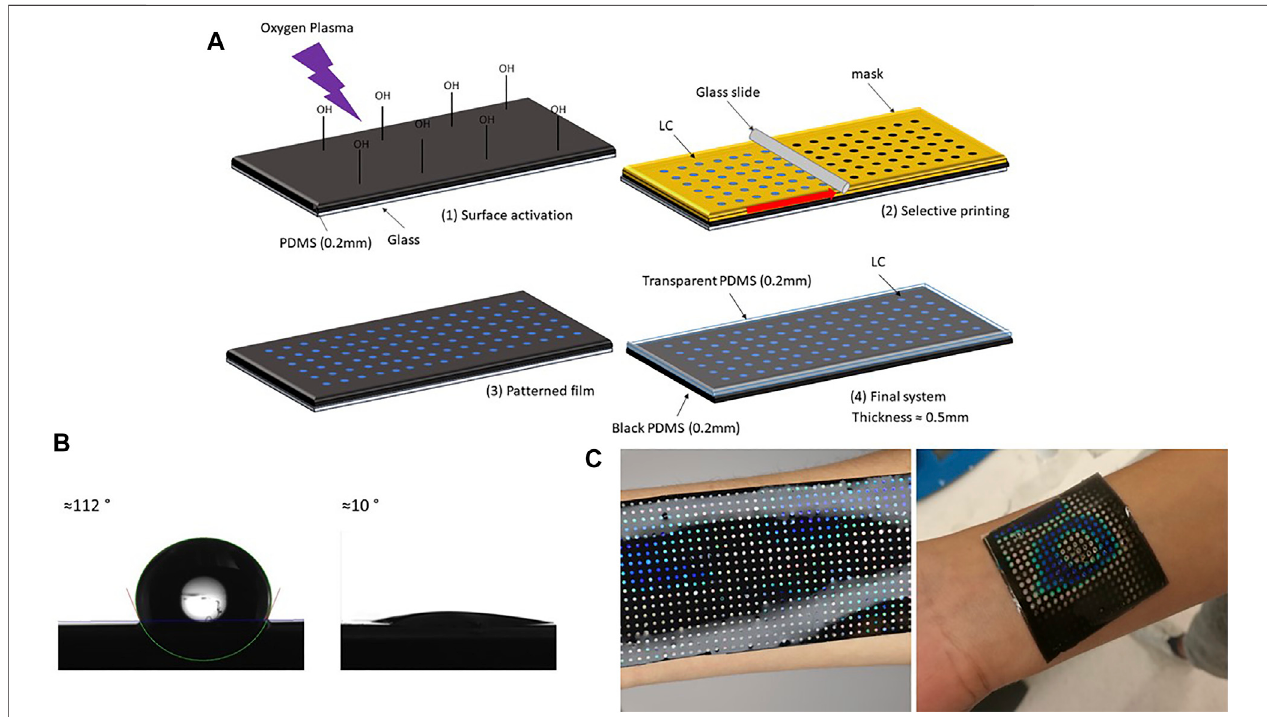
FIGURE 1 | Liquid crystal sensing patch with arrays: production steps. (A) Schematic description of LC sensing patch preparation: (1) thin layer (200 μ m) of black PDMS (PDMS and CB) was spin-coated on a glass substrate, after curing thin fi lm was transformed into hydrophilic surface using oxygen plasma (2) patterned paper mask (thickness 100 μ m) was glued on top of PDMS fi lm, and a drop of LC was poured on top of the mask. A uniform layer was created by blade coating (3) mask was removedwhenLCcooleddown(4)anotherthinlayeroftransparentPDMSwasspin-coatedontop.Aftercuringattheroomtemperaturepatchwaspeeledofffrom the glass. (B) PDMS contact angle before and after oxygen plasma treatment. (C) Different forms of LC patches adapting to different body parts.